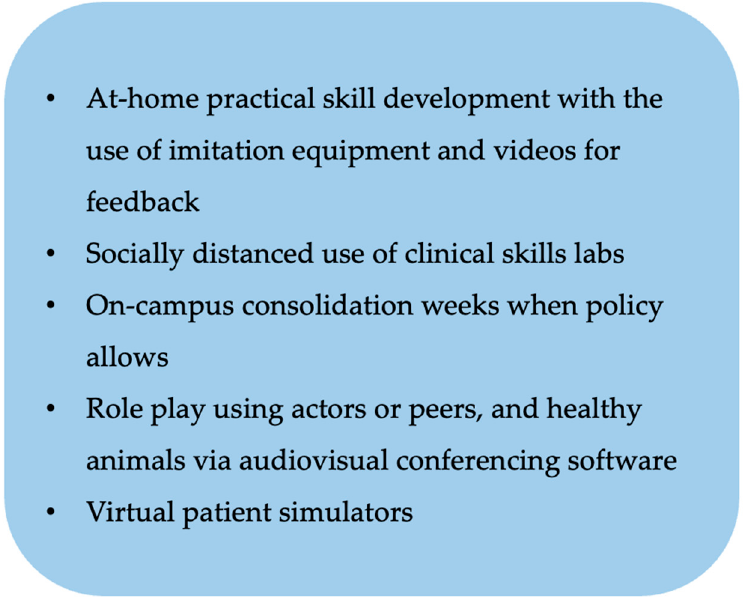
Figure 3. Mitigating approaches for delivering practical and clinical skills content during the Covid-19 pandemic.